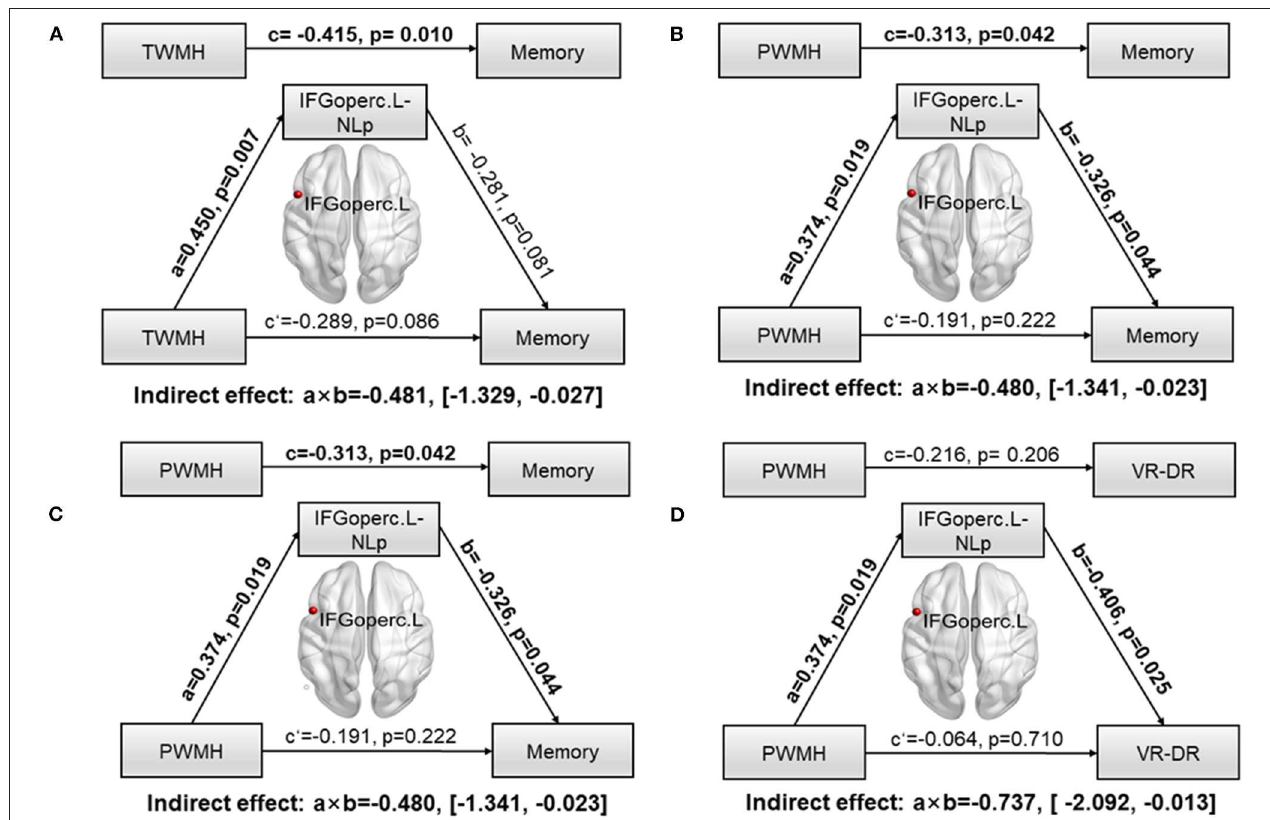
FIGURE 3 | Path models of WMH on memory tested by the mediation analysis. Significant pathways were highlighted in bold characters. For each connection, the standard coefficient (a, b, c, c ′ ) and P -value were shown. The indirect mediation effect (a × b) and its 95% confidence interval was also shown. (A) Association between TWMH and memory deficit was significantly mediated by NLp of IFGoperc.L (Indirect effect: − 0.481; 95% confidence interval: − 1.329, − 0.027). (B) Association between PWMH and memory deficit was significantly mediated by NLp of IFGoperc.L (Indirect effect: − 0.480; 95% confidence interval: − 1.341, − 0.023). (C) Association between TWMH and VR-DR was significantly mediated by NLp of IFGoperc.L (Indirect effect: − 0.513; 95% confidence interval: − 2.129, − 0.019). (D) Association between PWMH and VR-DR was significantly mediated by NLp of IFGoperc.L (Indirect effect: − 0.737; 95% confidence interval: − 2.092, − 0.013). WMH, white matter hyperintensity; IFGoperc, opercular part of inferior frontal gyrus; L, left; NLp, nodal path length; PWMH, periventricular white matter hyperintensity; TWMH, total white matter hyperintensity; VR-DR, Visual Reproduction–Delay